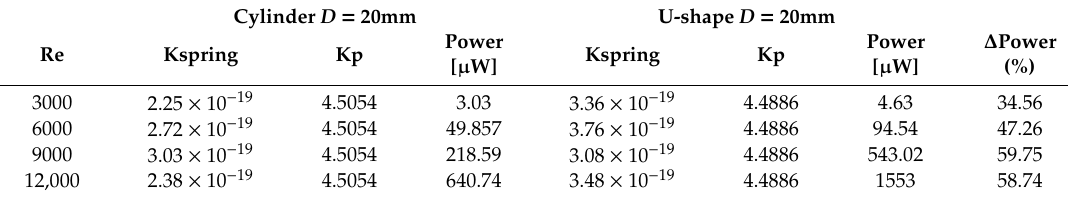
Table 5. Results of the JADE optimization algorithm for the cylinder and U-shaped oscillating bodies with D = 20 mm.